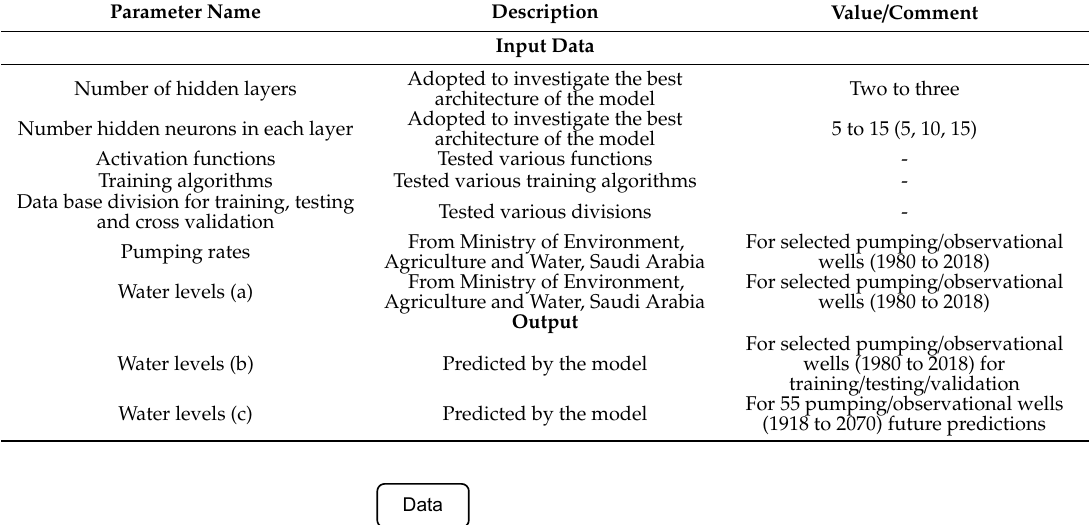
Table 3. Input and output data / parameters for ANN.